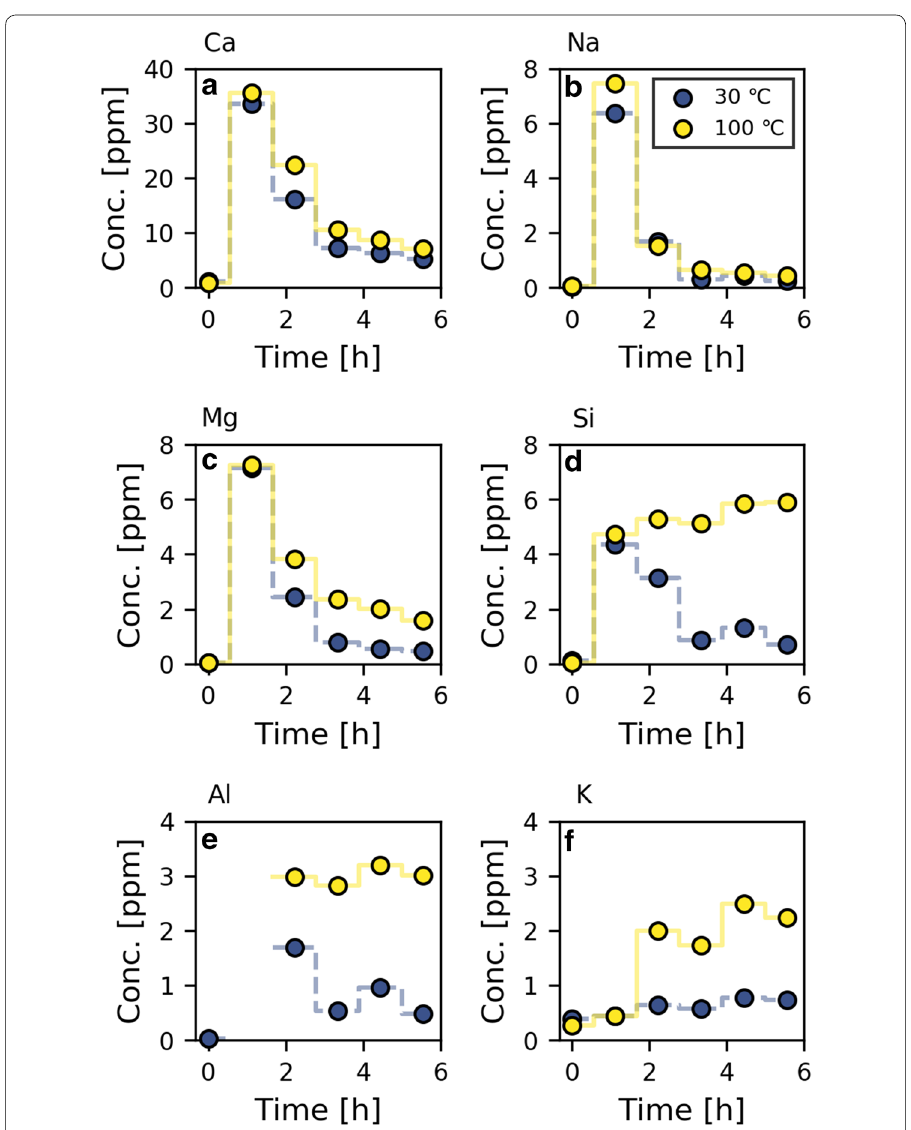
Fig. 9 Inductively coupled plasma atomic emission spectroscopy (ICP-AES) data. a Calcium, b sodium, c magnesium, d silicon, e aluminium, and f potassium. Dark blue symbols refer to data collected during the room-temperature ( 30 ◦ C ) experiment (Fig. 8); light-coloured (yellow) symbols refer to data collected during the high-temperature ( 100 ◦ C ) experiment (Fig. 8). All concentrations are shown in parts per million